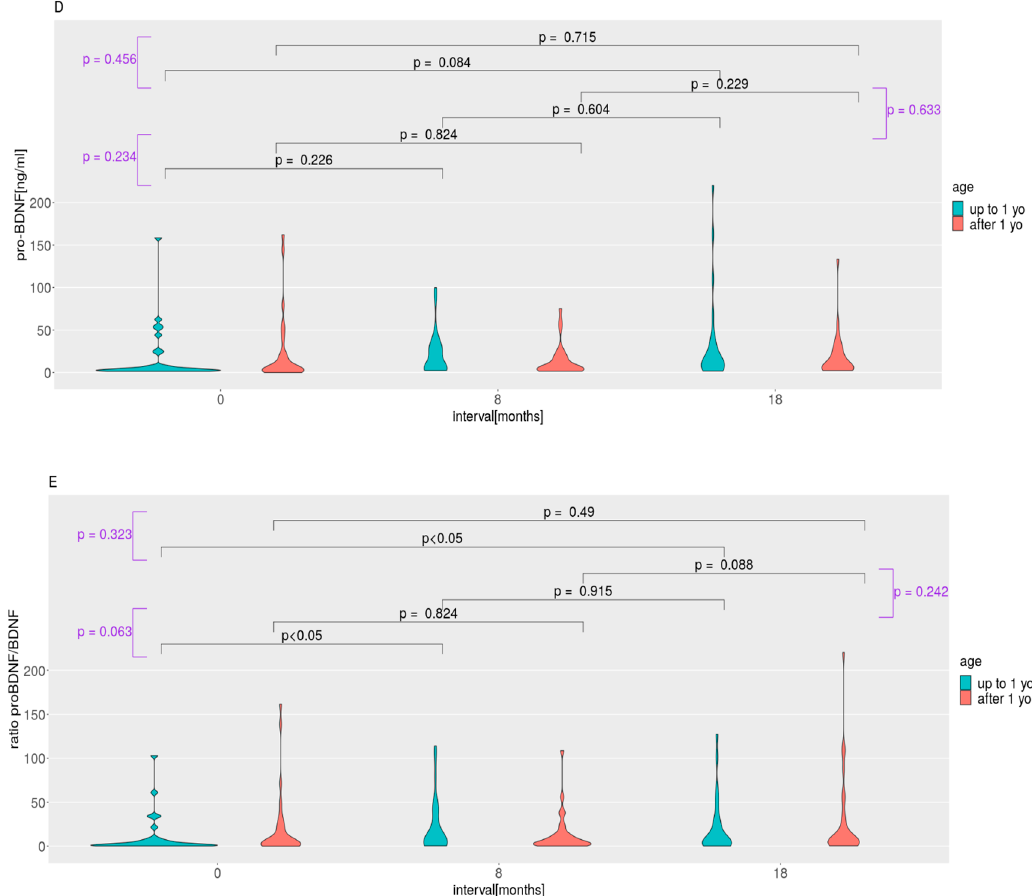
Figure 1. LEAQ score ( A ) and plasma levels of MMP-9 ( B ), BDNF ( C ), and pro-BDNF ( D ) as well as the pro-BDNF/BDNF ratio ( E ) at all three follow-up intervals in the two study groups: one in which CI activation occurred before 1 year (N = 29, cyan) and the other where CI activation took place after 1 year (N = 30, red). There were differences in the changes in the means of LEAQ, MMP-9, BDNF, and pro-BDNF, as well as the pro-BDNF/BDNF ratio, between the subgroups over the follow-up intervals ( p -values, violet) as well as changes in the means of LEAQ, MMP-9, BDNF, and pro-BDNF as well as the pro-BDNF/BDNF ratio over the follow-up within both subgroups ( p -values, black). Statistical differences are shown with p -values at the top. Table 1. LEAQ scores and plasma levels of MMP-9, BDNF, and pro-BDNF, as well as the pro- BDNF/BDNF ratio, at all three follow-up intervals in the two study groups: one in which CI activation occurred before 1 year (N = 29) and the other where CI activation took place after 1 year (N = 30). Paired comparisons are of the mean values between the groups.